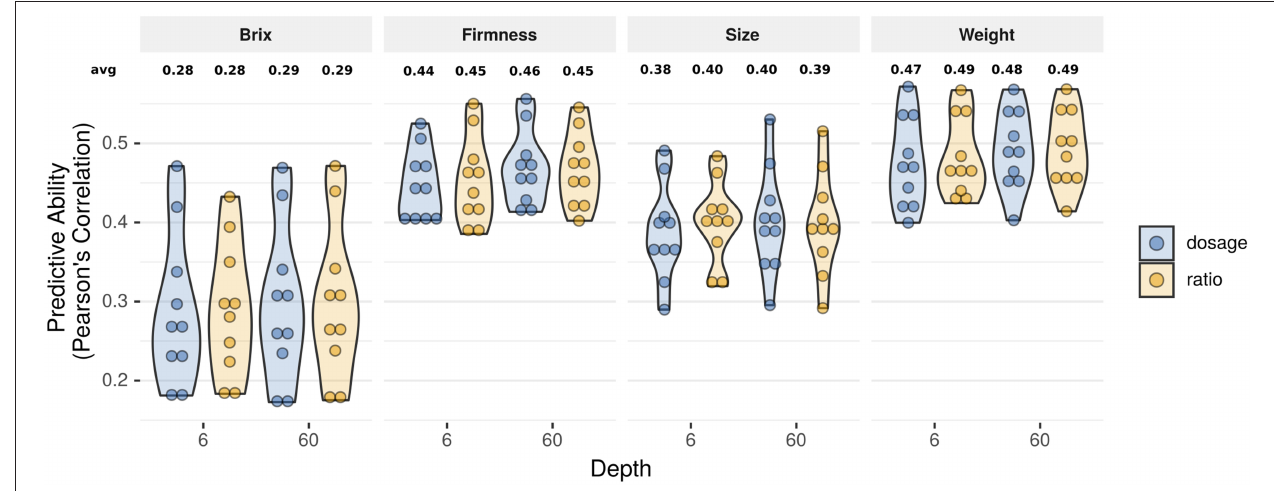
FIGURE 3 | Violin plot with predictive ability considering two genotype calling approaches (dosage and ratio) under two sequencing depth scenarios (6 × and 60 × ) for four fruit quality traits in blueberry using 10-fold cross validation. Each circle represents one cross validation fold result.